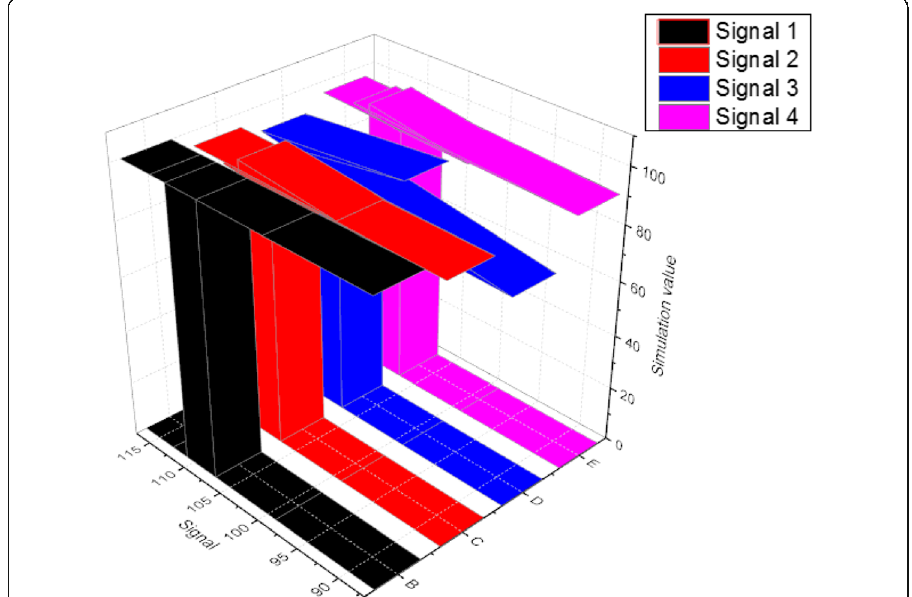
Fig. 3 Particle swarm evolution curve of our